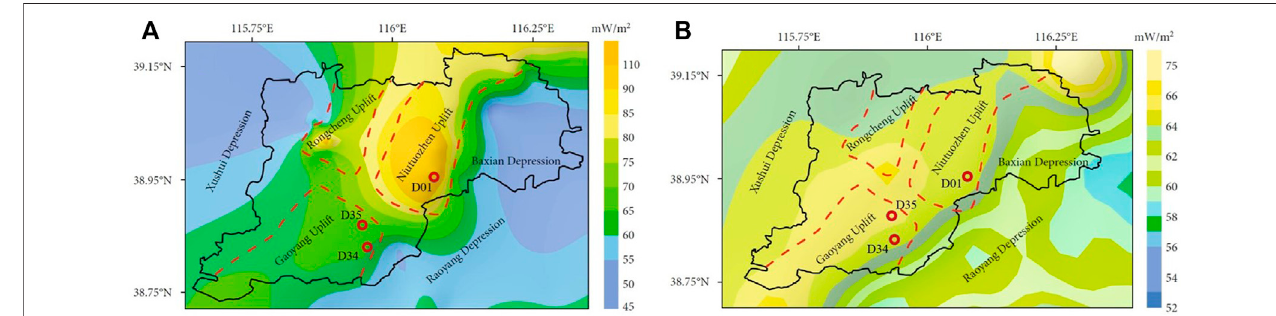
Frontiers in Earth Science |